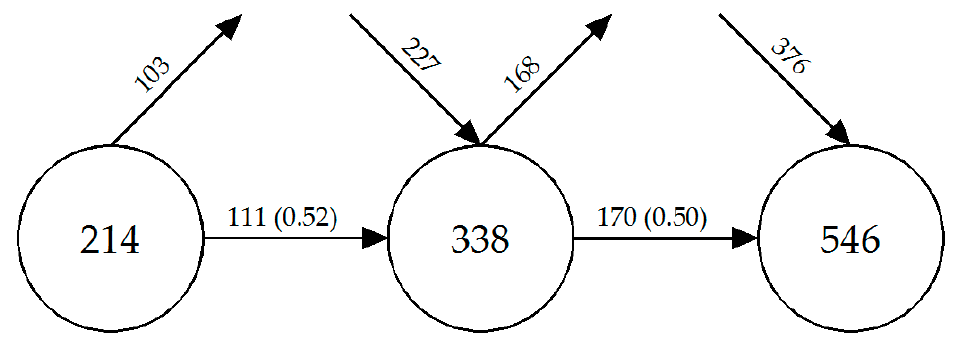
Figure 3. Keywords between periods. Source: Prepared by the authors on the basis of SciMAT data.